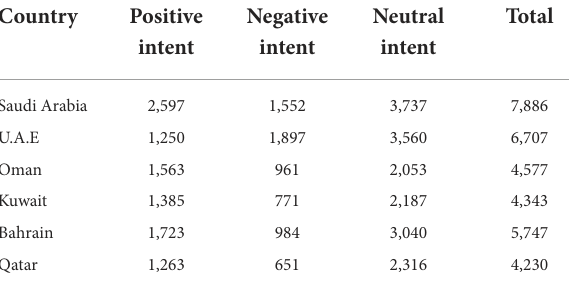
TABLE 2 Comparing the three sentiments of tweets from the Gulf countries during the COVID-19 pandemic.